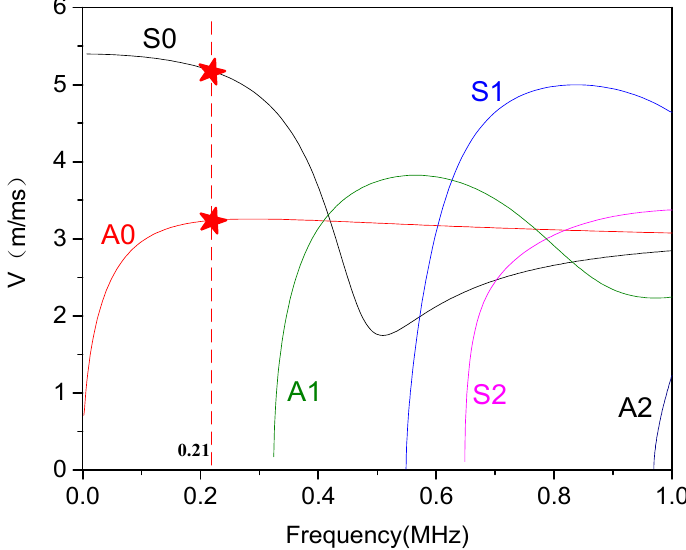
Figure 2. Dispersion curves of group velocity for a 5 mm length notch plate.